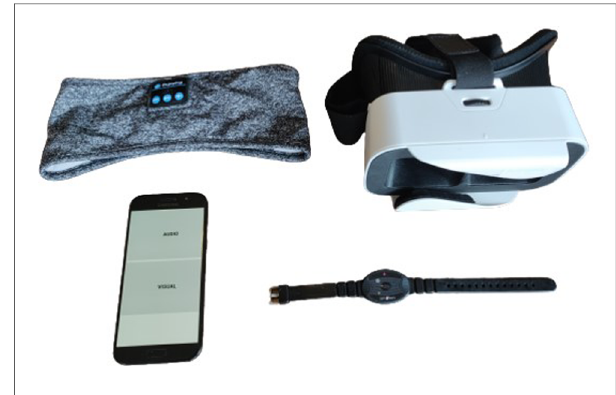
FIGURE 1 Equipment used; sleep headband with integrated wireless headphones, headset to hold phone for visual stimulation mode, smartphone with hBET app loaded, motionwatch 8 actigraph